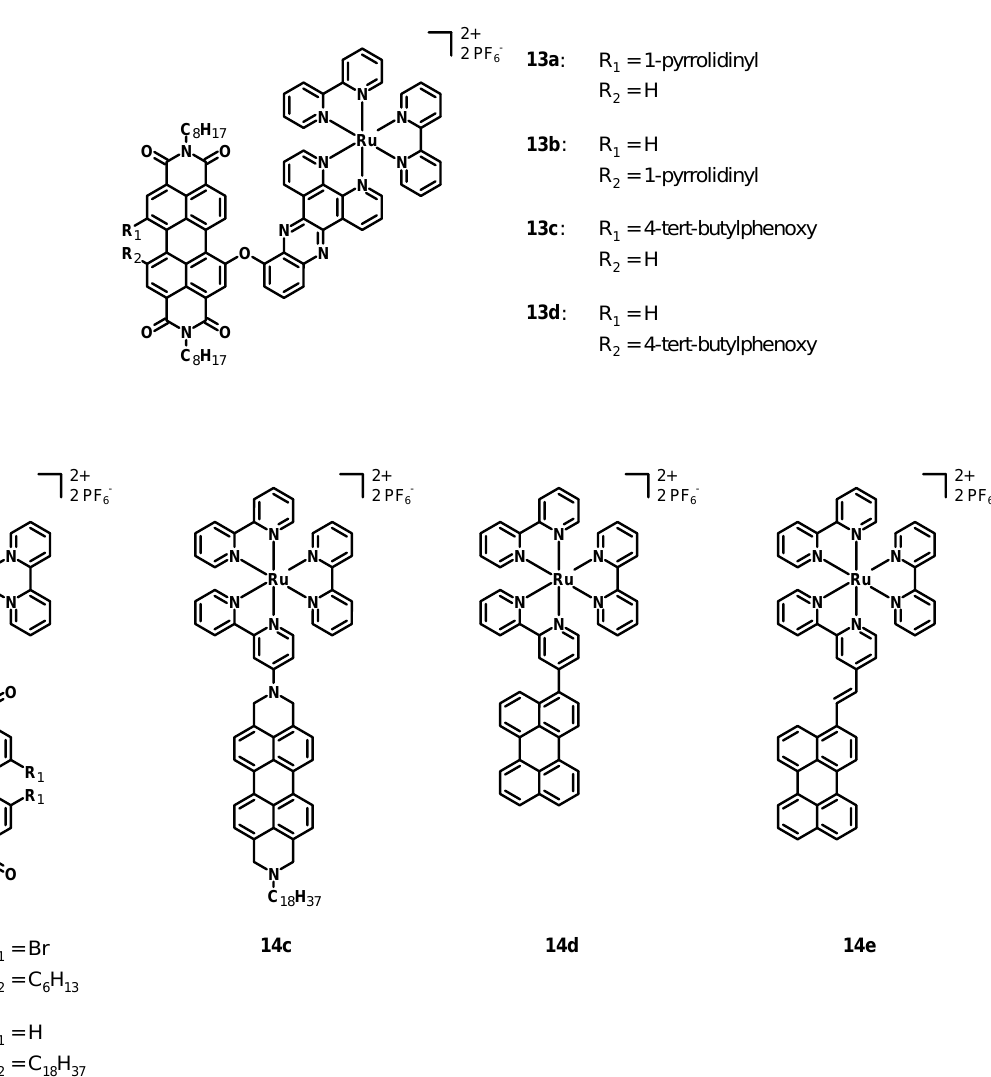
Figure 6. Structures of complexes 13a – d and 14a – e .